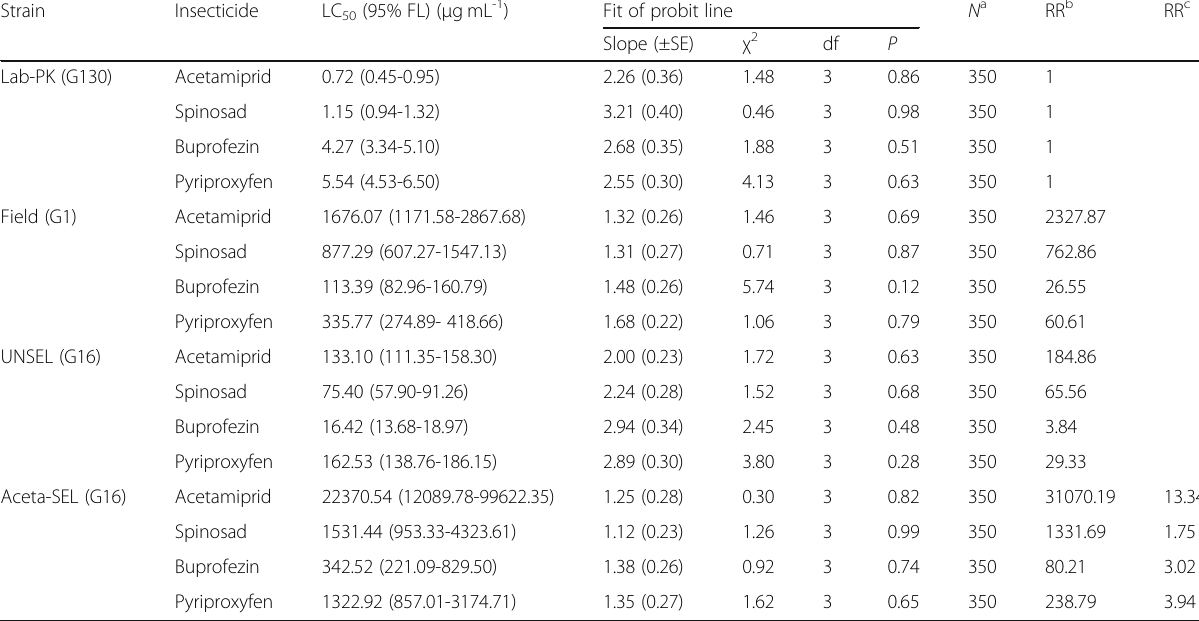
Table 1 Response of various insecticides to Lab-PK, Field, UNSEL and Aceta-SEL populations of Chrysoperla carnea